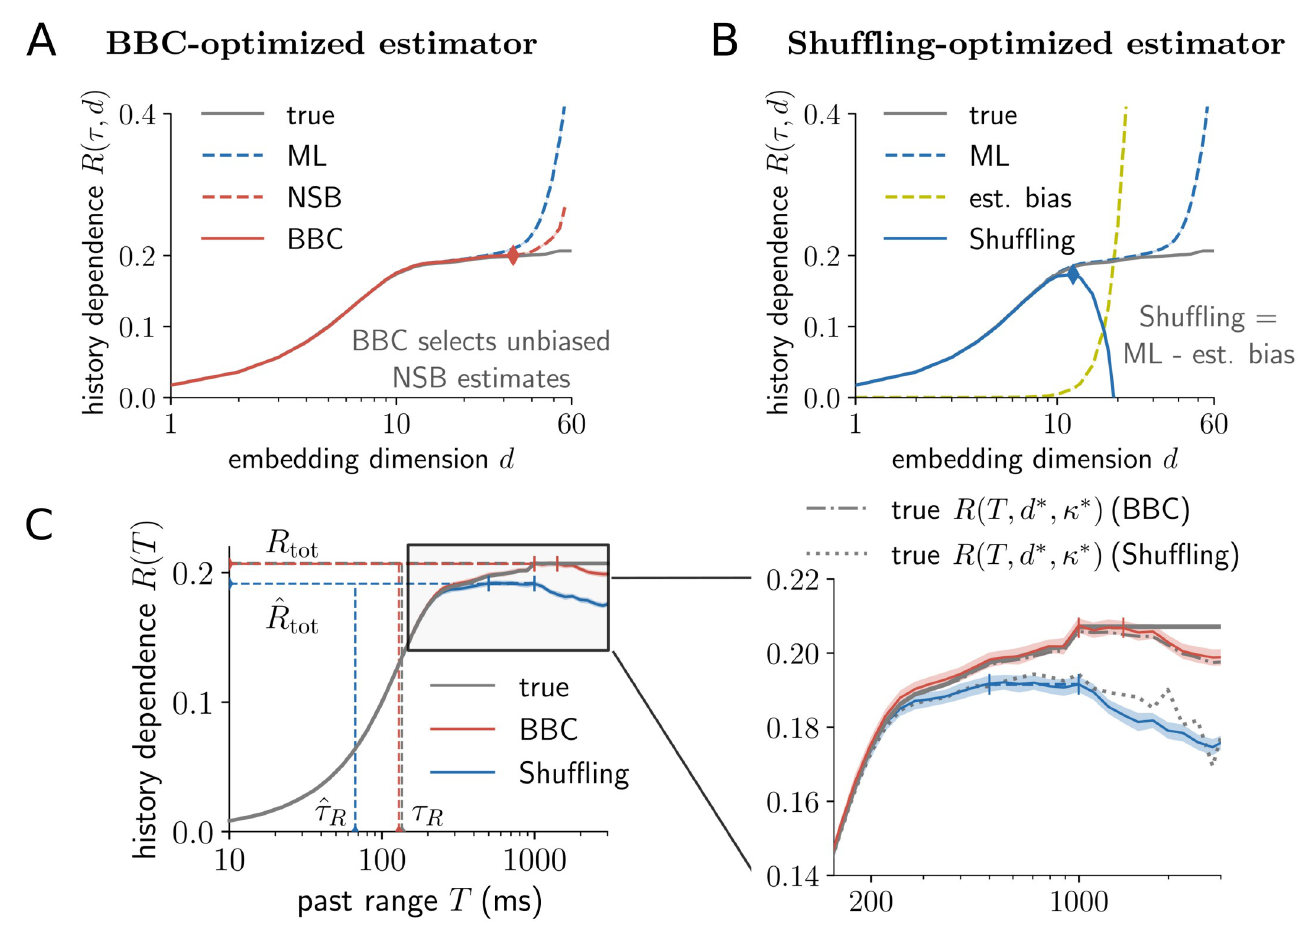
Fig 5. Embedding optimization captures history dependence for a neuron model with long-lasting spike adaptation. Results are shown for a generalized leaky integrate-and-fire (GLIF) model with long-lasting spike frequency adaptation [3, 43] with a temporal depth of one second (Methods and material). (A) For illustration, history dependence R ( τ , d ) was estimated on a simulated 90 minute recording for different embedding dimensions d and a fixed bin width τ = 20 ms. Maximum likelihood (ML) [28] and Bayesian (NSB) [33] estimators display the insufficient embedding versus estimation bias trade-off: For small embedding dimensions d , the estimated history dependence is much smaller, but agrees well with the true history dependence R ( τ , d ) for the given embedding. For larger d , the estimated history dependence ^ R ð t ; d Þ increases, but when d is too high ( d > 20), it severely overestimates the true R ( τ , d ). The Bayesian bias criterion (BBC) selects NSB estimates ^ R ð t ; d Þ for which the difference between ML and NSB estimate is small (red solid line). All selected estimates are unbiased and agree well with the true R ( τ , d ) (grey line). Embedding optimization selects the highest, yet unbiased estimate (red diamond). (B) The Shuffling estimator (blue solid line) subtracts estimation bias on surrogate data (yellow dashed line) from the ML estimator (blue dashed line). Since the surrogate bias is higher than the systematic overestimation in the ML estimator (difference between grey and blue dashed lines), the Shuffling estimator is a lower bound to R ( τ , d ). Embedding optimization selects the highest estimate, which is still a lower bound (blue diamond). For A and B, shaded areas indicate ± two standard deviations obtained from 50 repeated simulations, which are very small and thus hardly visible. (C) Embedding-optimized BBC estimates ^ R ð T Þ (red line) yield accurate estimates of the model neuron’s true history dependence R ( T ), total history dependence R tot and information timescale τ R (horizontal and vertical dashed lines). The zoom-in (right panel) shows robustness of both regularization methods: For all T the model neuron’s R ( T , d � , κ � ) lies within errorbars (BBC), or consistently above the Shuffling estimator that provides a lower bound. Here, the model’s R ( T , d � , κ � ) was computed for the optimized embedding parameters d � , κ � that were selected via BBC or Shuffling, respectively (dashed lines). Shaded areas indicate ± two standard deviations obtained by bootstrapping, and colored vertical bars indicate past ranges over which estimates ^ R ð T Þ were averaged to compute ^ R (Materials and tot